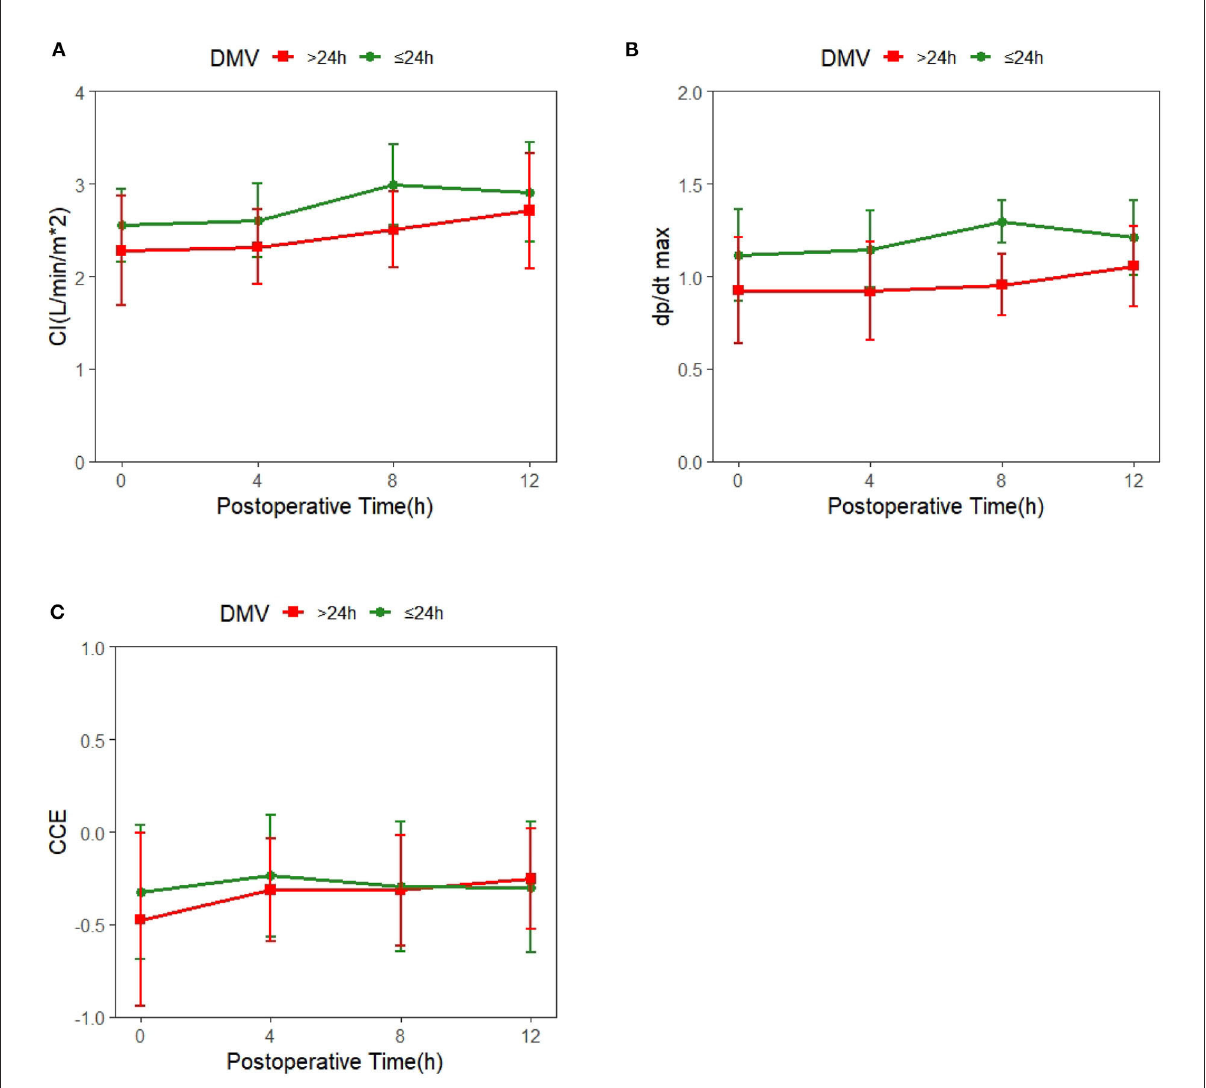
FIGURE1 Trends of systemic hemodynamic value over time in patients with different duration of mechanical ventilation (DMV); the red line represents DMV > 24h, and the green line represents DMV ≤ 24h. (A) Time-dependent changes in cardiac index(CI). (B) Time-dependent changes in cardiac cycle efficiency (CCE). (C) Time-dependent changes in the maximal slope of the systolic upstroke (dp/dt max